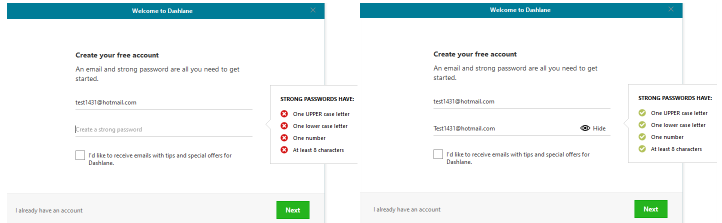
Figure A19. Users of Dashlane can create a master password using their email